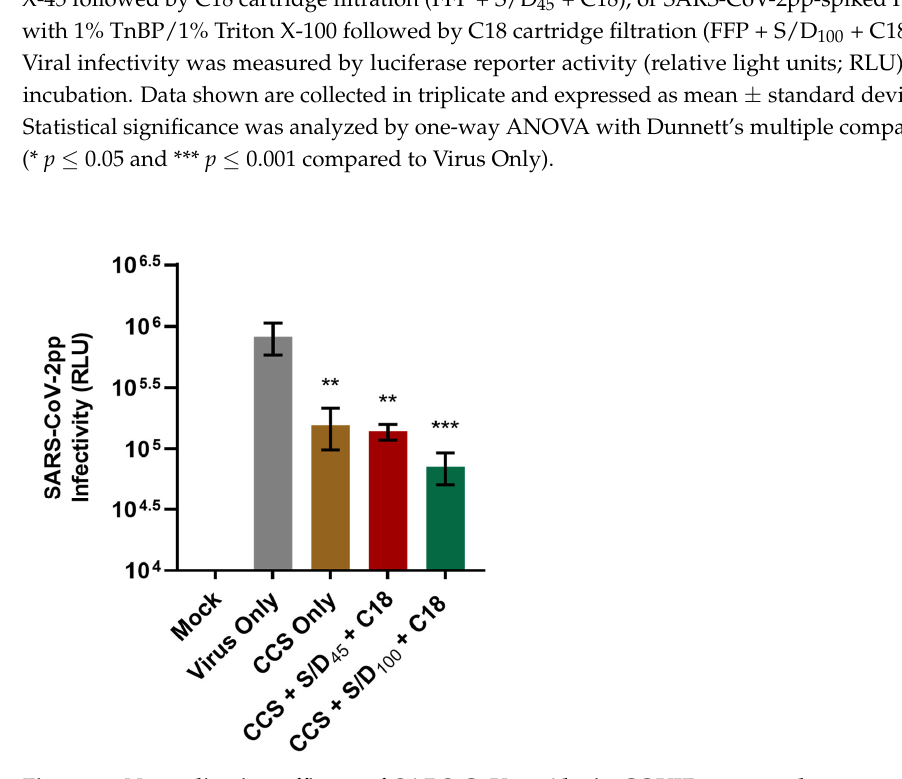
Figure 4. Neutralization efficacy of SARS-COV-2 nAbs in COVID-19 Convalescent Serum (CCS) were preserved after the S/D inactivation protocols. Patient-derived CCS was treated with the S/D inactivation protocols (CCS + S/D 100 + C18 or CCS + S/D 45 + C18) or left untreated (CCS Only) before incubation with SARS-COV-2pp at 37 °C for 1 h in an Eppendorf tube. The CCS–virus mixture was